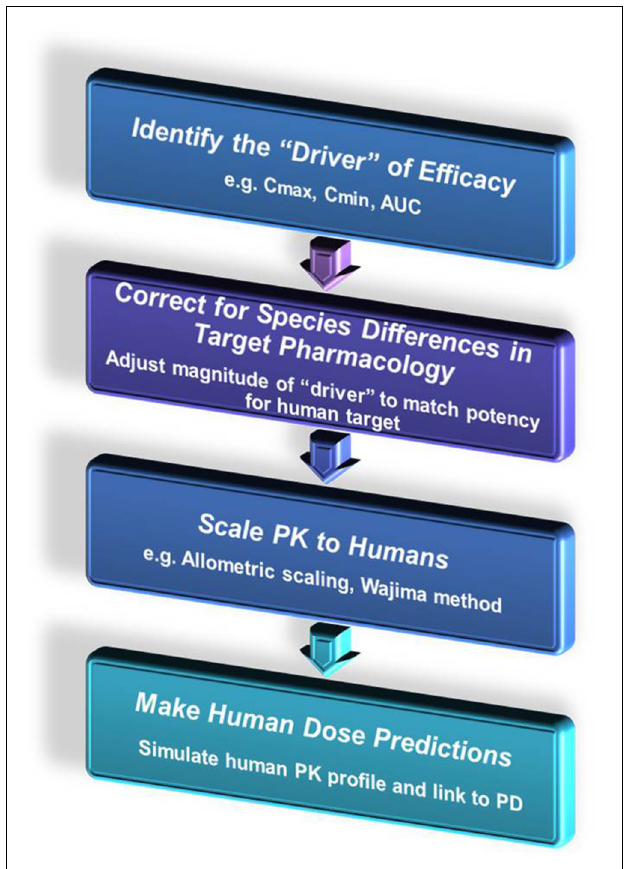
FIGURE 13 | Extrapolating preclinical PK/PD data to the clinic.